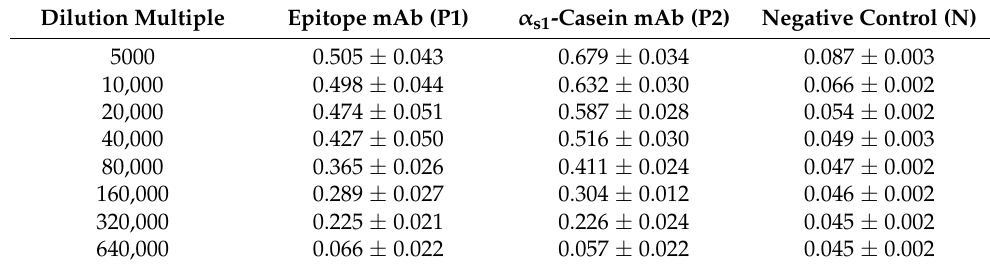
Table 2. Absorbance of mAb titer against α s1 -casein and epitopes.